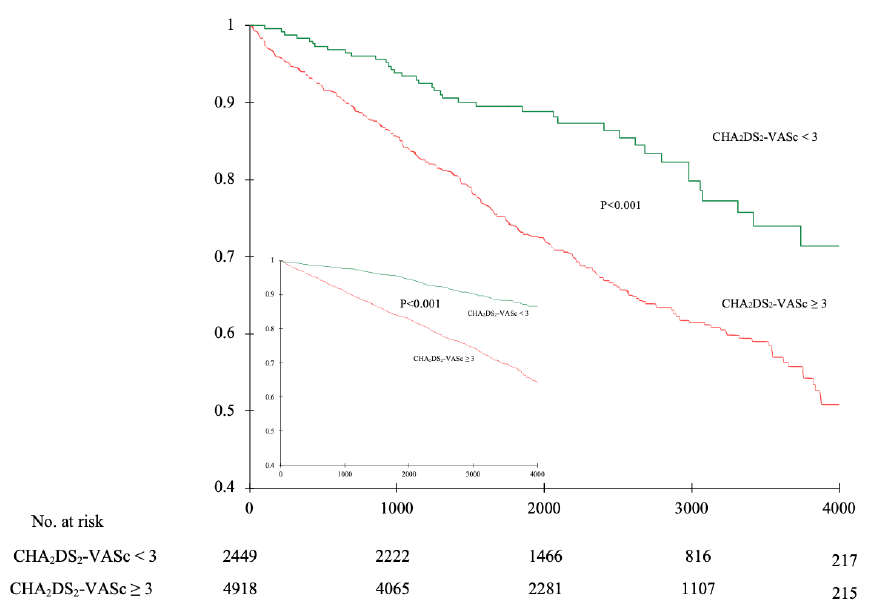
Figure 5. Kaplan – Meier survival analysis of all-cause mortality in relation to the CHA 2 DS 2 -VASc score in the overall study population (large graph). The inner graph represents the comparison in patients with atrial fibrillation.